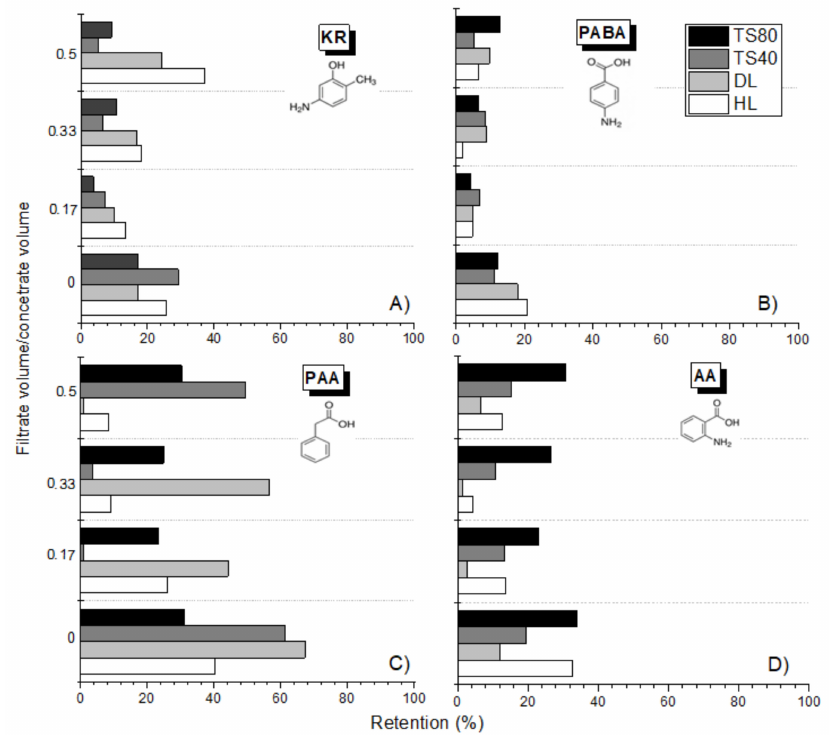
Figure 6. Dependence of retention on the concentration ratio (filtrate volume to concentrate volume ratio) for selected compounds for various types of commercial membranes: ( A ) 5-Amino-o-kresol (KR); ( B ) p-Aminobenzoic Acid (PABA); ( C ) Phenyloacetic Acid (PAA); ( D ) Anthranilic Acid